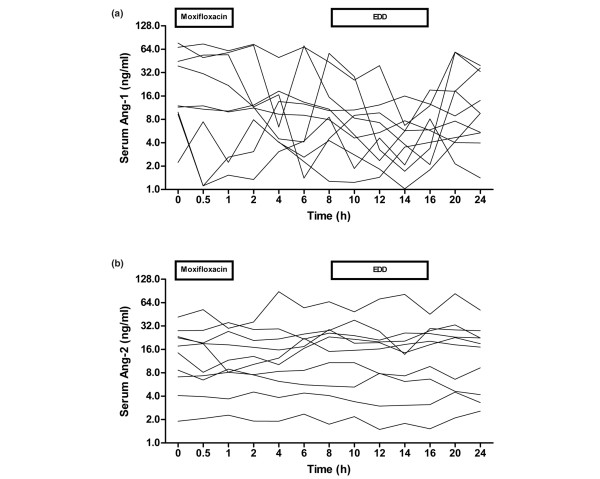
Angiopoietin-1 and angiopoietin-2 concentrations are stable during a 24-hour time course in critically ill patients. Intraindividual (a) angiopoietin-1 (Ang-1) serum concentrations showed higher variability within the 24-hour study period than (b) angiopoietin-2 (Ang-2) concentrations (P = 0.888 and P = 0.205). Serum concentrations of Ang-1 and Ang-2 were not altered significantly within 8 hours after the first administration of intravenous moxifloxacin (P = 0.885 and P = 0.372), or during 8 hours of extended daily dialysis (EDD) (P = 0.542 and P = 0.423). Each line represents a single patient.